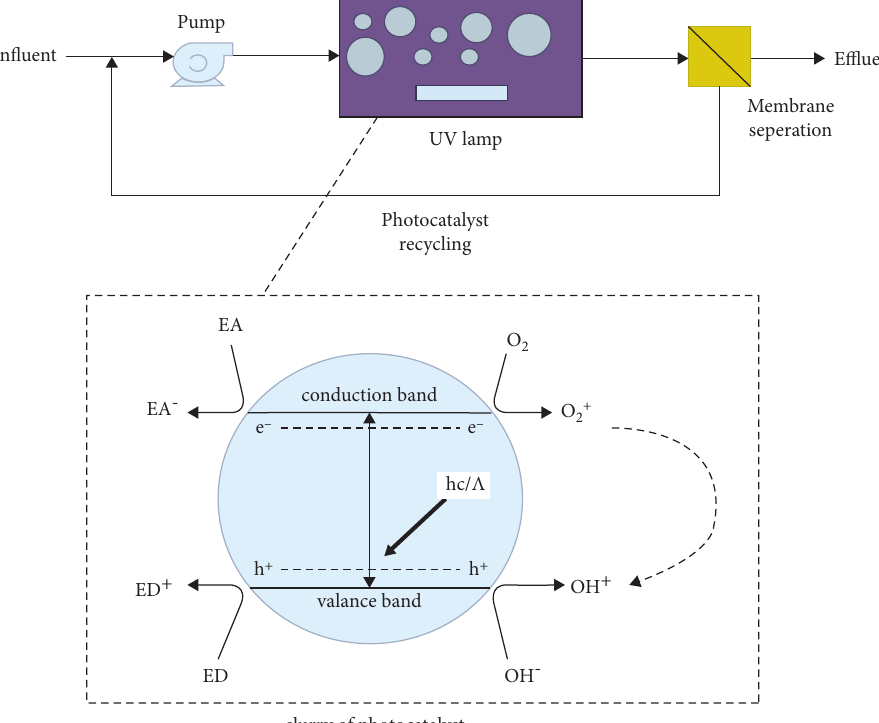
Figure 23: Photocatalytic advanced oxidation process system containing a reactor with suspended photocatalysts, UV-lamp (light source) for TiO 2 , and membrane filter that recovers the used catalyst. Diagram reproduced from Hodges et al. [338]. Challenges and prospects of advanced oxidation water treatment processes using catalytic nanomaterials. Nature Nanotechnology